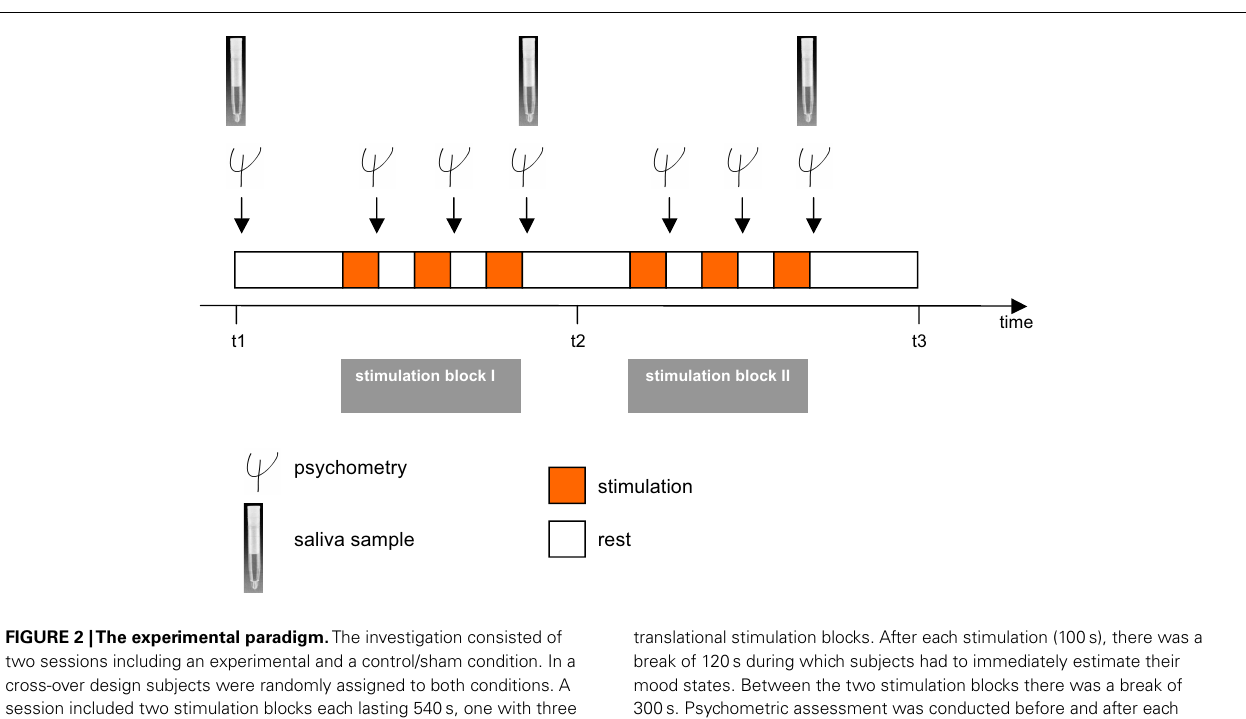
FIGURE 2 |The experimental paradigm. The investigation consisted of two sessions including an experimental and a control/sham condition. In a cross-over design subjects were randomly assigned to both conditions. A session included two stimulation blocks each lasting 540s, one with three rotational stimulations (yaw, pitch, roll) and one with translational vestibular stimulations (surge, heave, sway) which were performed on a hexapod. Translational and rotational stimulation blocks were also randomized, as were all forms of vestibular stimulation within the rotational and